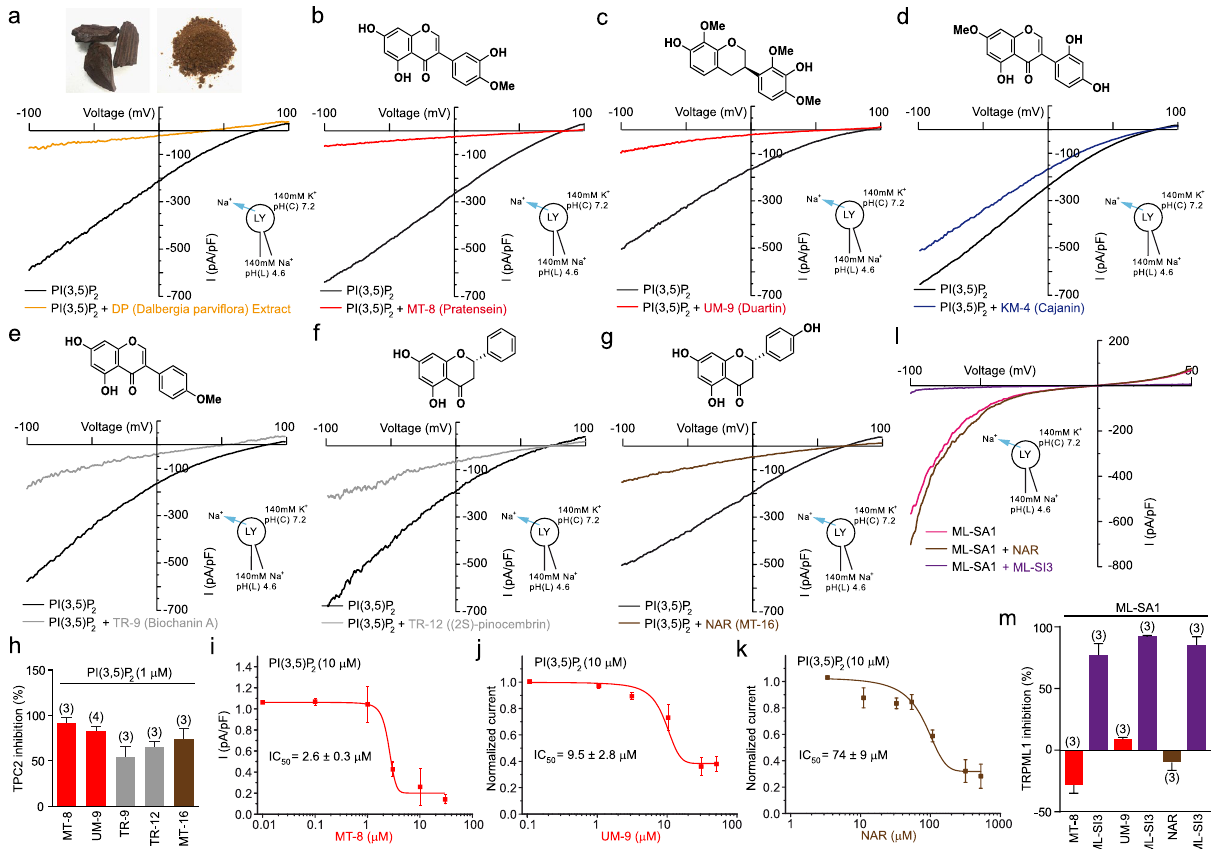
Figure 3. Flavonoids as inhibitors of TPC2 channel activity. ( a ) Heartwood and extract from D. parviflora (upper panel), and endolysosomal patch-clamp measurement demonstrating effect of the extract (10 µg/ ml) to block TPC2 stimulated by PI(3,5)P 2 (1 µM). Shown is a representative PI(3,5)P 2 -evoked current from enlarged endolysosomes isolated from HEK293 cells stably expressing human TPC2 (hTPC2). Recordings were carried out using standard bath and pipette solutions and applying ramp protocols (− 100 mV to + 100 mV over 500 ms) every 5 s at a holding potential of -60 mV. ( b – g ) Similar recordings as shown in a using different flavonoids (10 µM, each) to block TPC2. Structures of the respective test compounds are shown on top of the I–V traces. ( h ) Shown are average current densities (mean ± SEM) at − 100 mV of experiments as shown in b – g . ( i – k ) Effect-response relationships of MT-8, UM-9, and NAR using 10 µM PI(3,5)P 2 for activation. ( l – m ) Data showing no blocking effect of MT-8 or NAR on TRPML1 (activation with 10 µM ML-SA1). As a positive control TRPML blocker ML-SI3 was